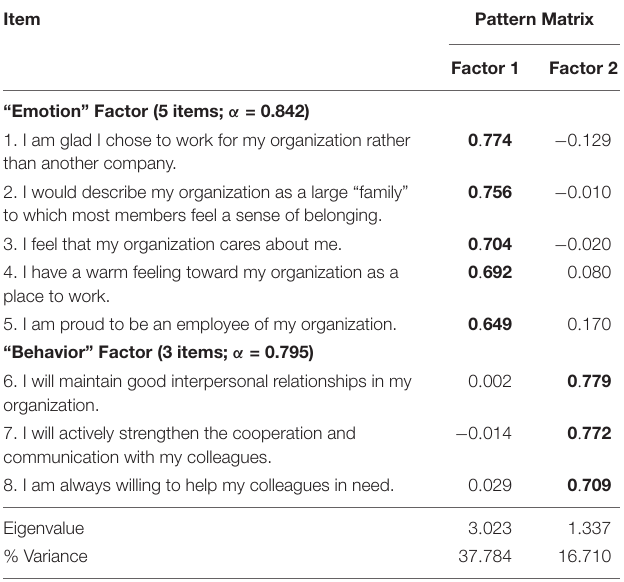
TABLE 1 | Factor loadings a for exploratory factor analyses with direct oblimin rotation of the Chinese Organizational Identification Questionnaire (COIQ; Study 1, n Study 1 − EFA = 203).